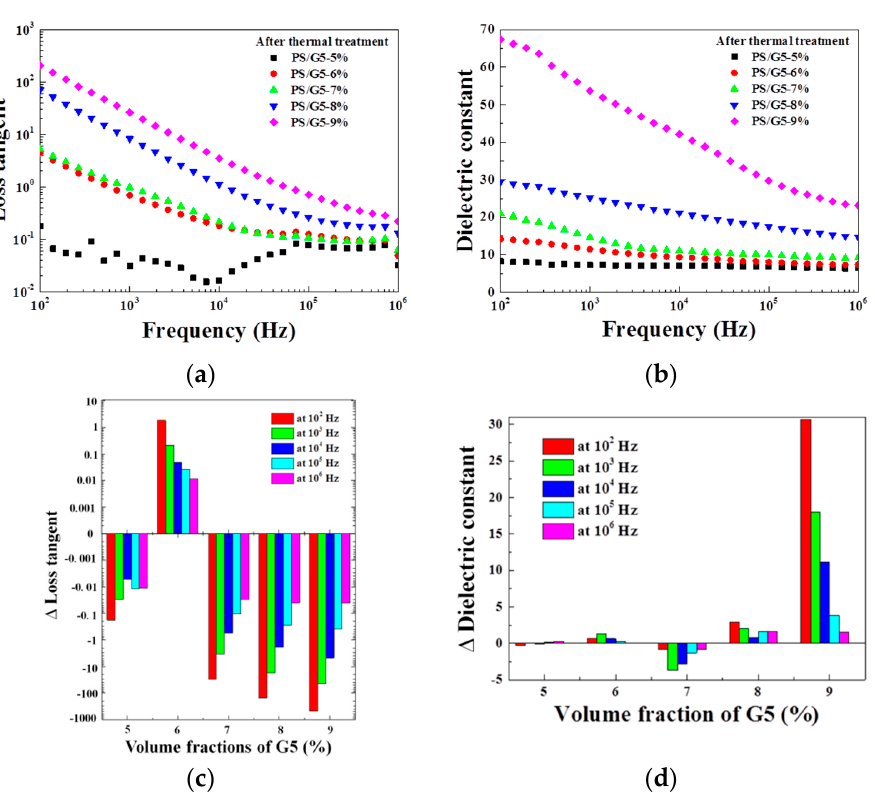
Figure 6. Frequency dependence of dielectric properties for PS/G5 composites series after the thermal treatment: ( a ) for tan δ and ( b ) for ε ’; ( c , d ) are the differences ( ∆ ) of the values of tan δ and ε ’ between before and after the thermal treatment at five frequencies, respectively.